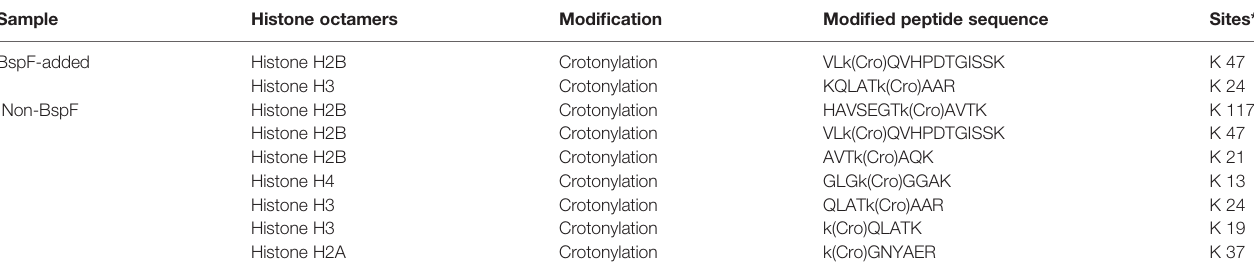
TABLE 1 | Mass spectrometry of